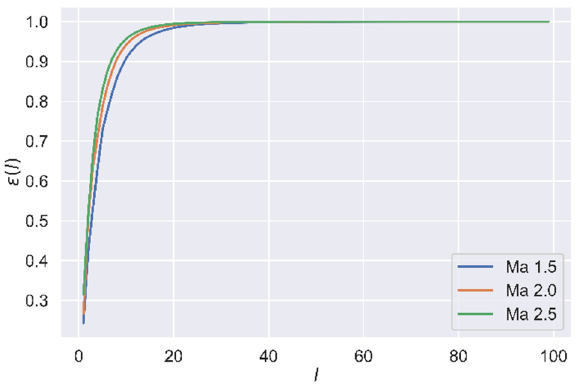
Figure 12. ℰ(ℓ) in the subzone in the SWBLI region in three different Mach numbers.